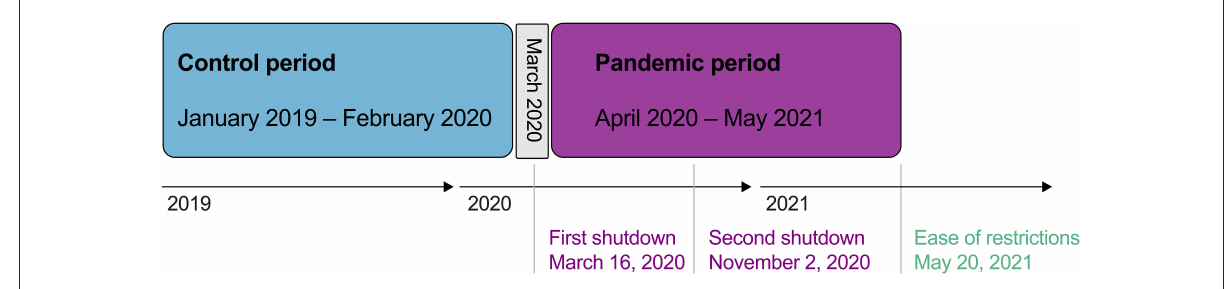
FIGURE1 Longitudinal time chart of analyzed periods and COVID-19 related shutdowns implemented in Berlin, Germany during 2020 and 2021.